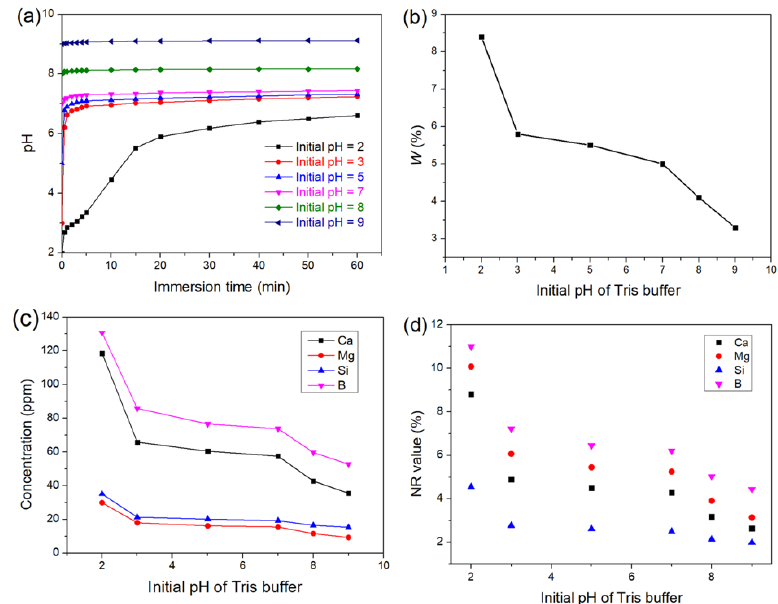
Figure 3. ( a ) pH variation, ( b ) weight loss, ( c ) ion release, and ( d ) NR value of the samples immersed in Tris buffers with different initial pH for 1 h.